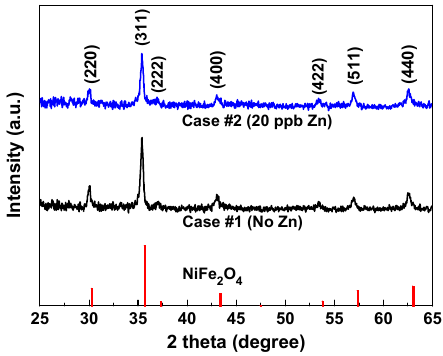
Figure 5. XRD spectra from fuel deposits formed under the conditions of Case #1 and Case #2.